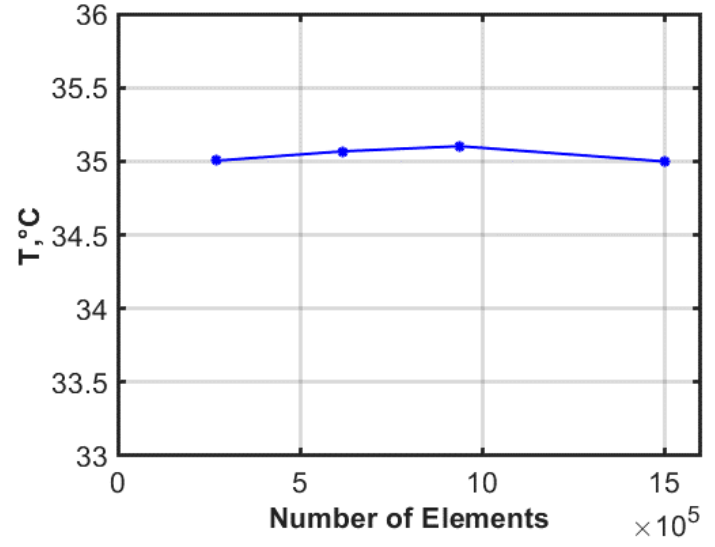
Figure 9. Mesh independence analysis.